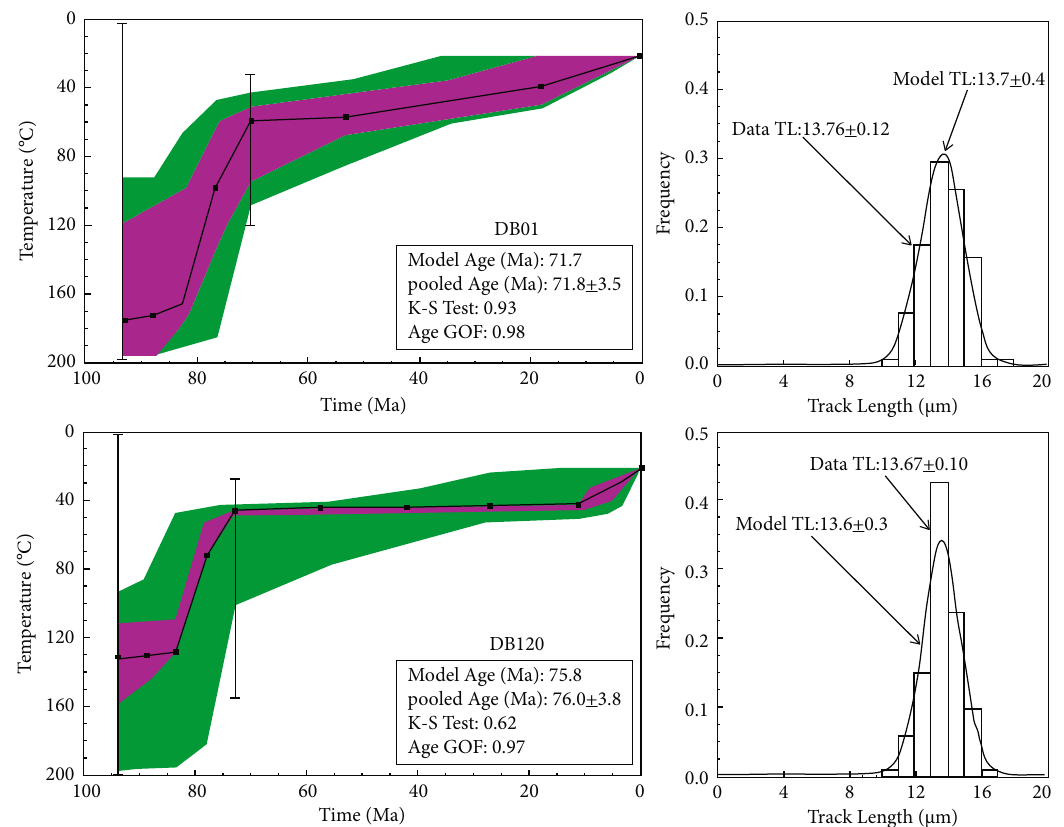
Figure 5: Exhumation history simulation diagram of AFT and histogram of AFT length distribution of the surrounding rocks. The solid line marks the best- fi t time-temperature path from which simulated data were derived. Green regions mark envelopes of statistically acceptable fi ts. Magenta regions indicate envelopes for statistically good fi ts. I-bars mark user-entered time-temperature